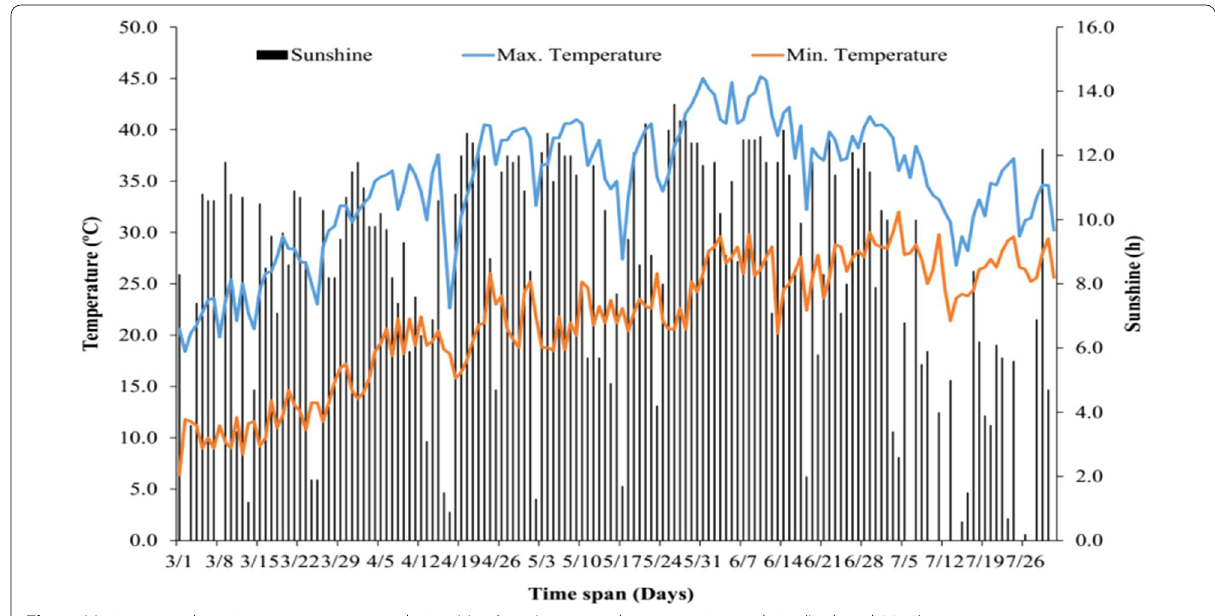
Fig. 4 Minimum and maximum temperatures during March to June months at experimental site (Ladowal